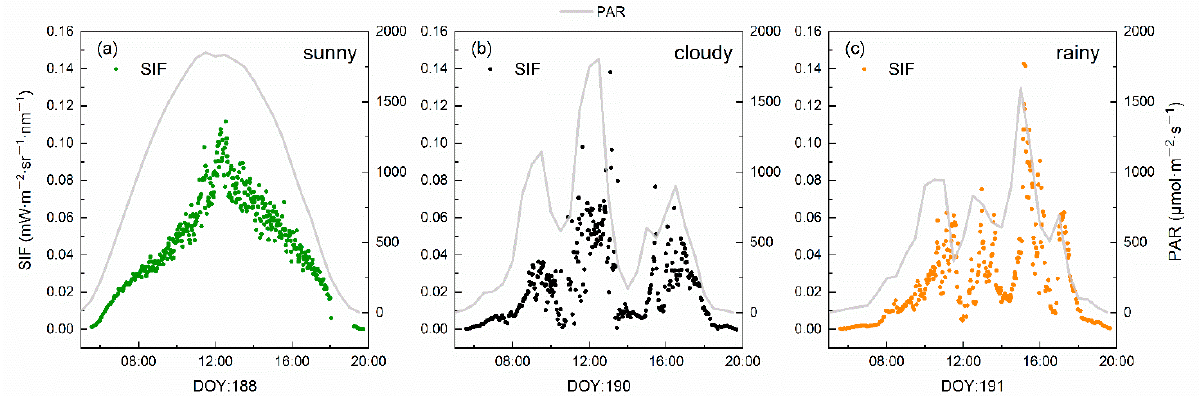
Figure 2. Diurnal variations in canopy solar-induced fluorescence under different sky conditions in 2019. DOY represents the day of the year. ( a ), ( b ) and ( c ) represent SIF on a sunny, cloudy, and rainy day (DOY 188, DOY 190, and DOY 191), sunny day ( a ) and cloudy day ( b ) were divided by clearness index. The gray line represents PAR in 30 min scale in the same day.